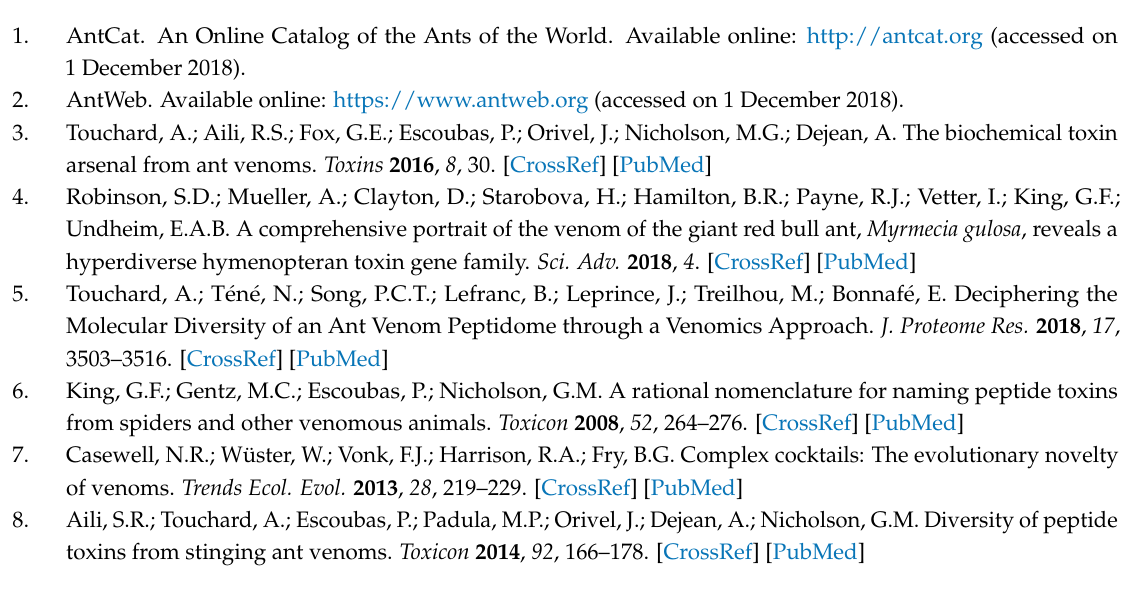
Table S1: Summary of statistical data measured for insecticidal activity in this study, Table S2: Peptide mass list from crude venom analysis of M. rubra , Figure S1: Technical replicate of a crude venom sample of the ruby ant M. rubra , Figure S2: Box-and-whisker plot of (a) molecular weight and (b) peptide sequence length distribution, Figure S3: Sequence alignment of U-MYRTX-MRArub1 with other antimicrobial peptides/peptide toxins, Figure S4: Helical wheel projection of U-MYRTX-MRArub1 and its most closely related ant-derived peptide homolog, U 12